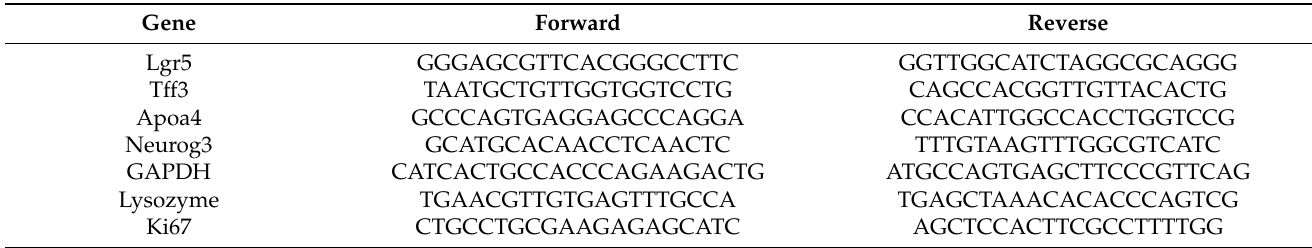
Table 3. Organoid primer sequence for